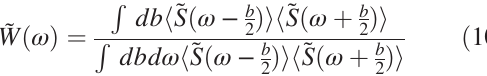
FIG. 1. The steps of the reconstruction method are outlined. (a) shows a set of simulated spectra. These are used to calculate G 2 ð ω ; δω Þ [Eq. (3)] and the weight function [Eq. (10)] W ð ω Þ (b). The titles of (a) and (b) act as labels for their color bars. Averaging G 2 ð ω ; δω Þ weighted by W ð ω Þ yields G 2 ð δω Þ [Eq. (11)] (d) and an average of the spectra yields h them allows us to extract widths and amplitudes that can be used to solve for σ The black lines indicate these reconstructed values. The blue horizontal lines indicate the true values of each parameter, whereas the green dot indicates the predicted value at the guessed SASE